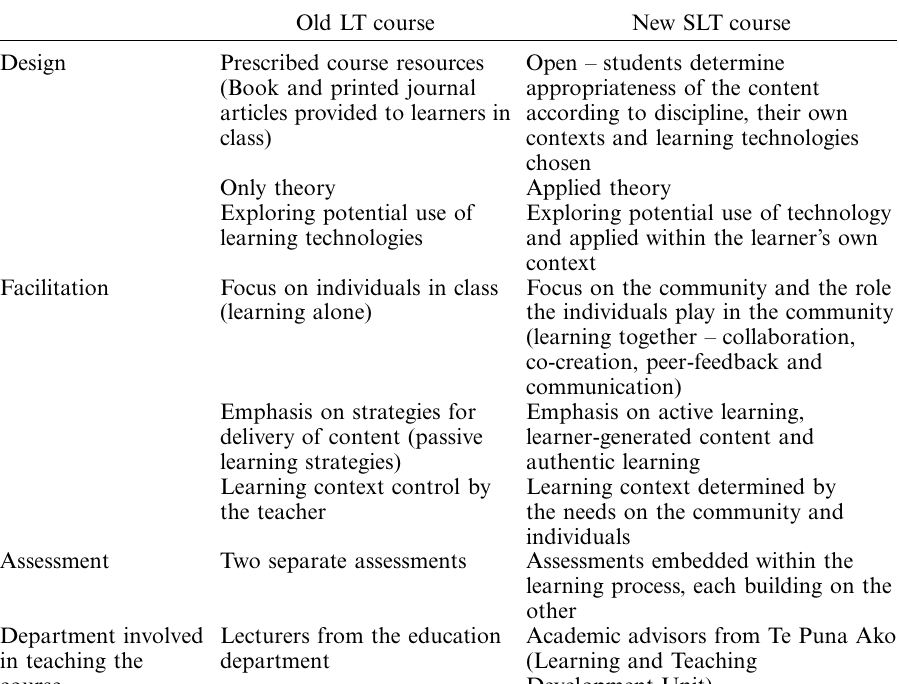
Table 1. Key differences in the redesign of the social learning technologies